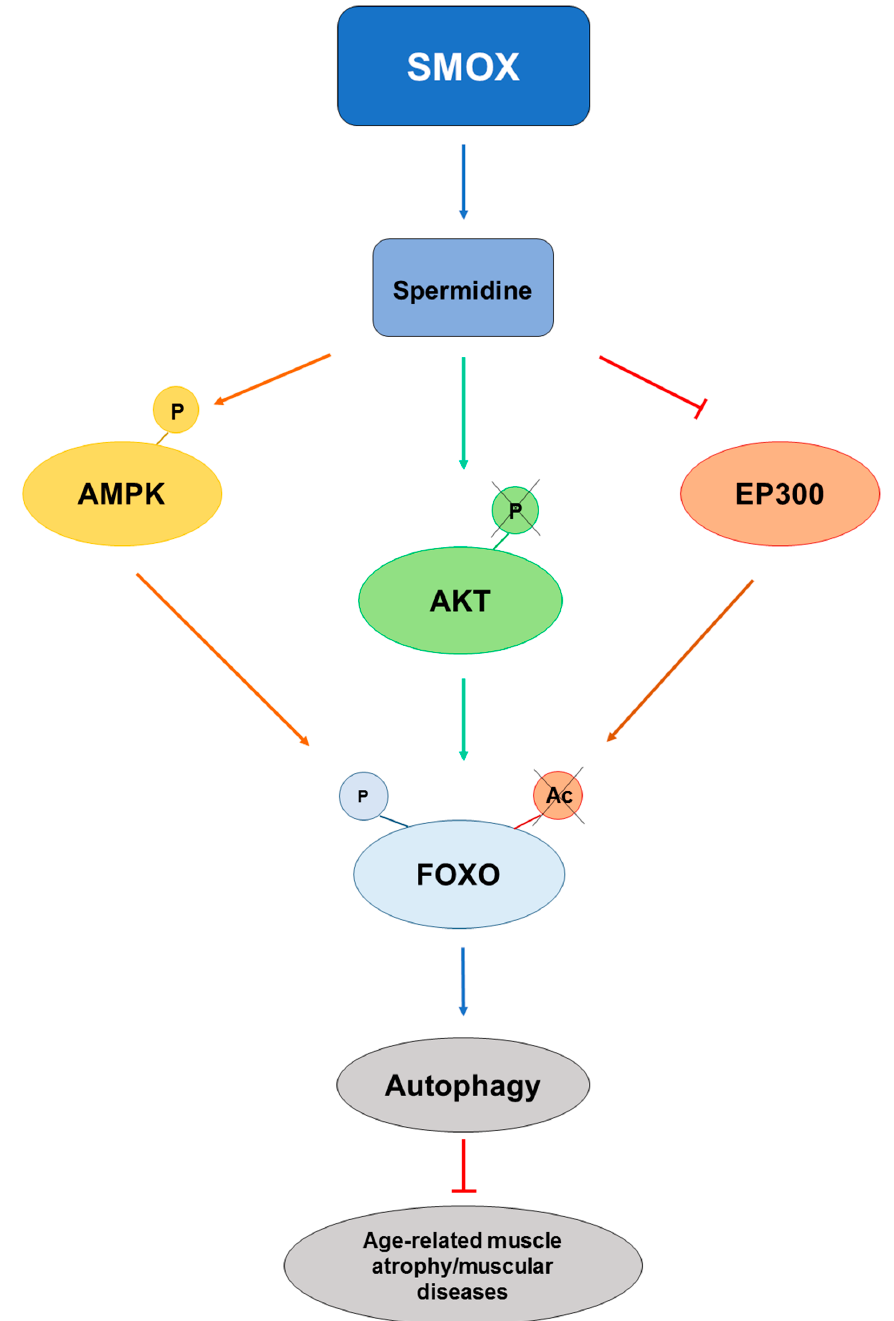
Figure 5. Schematic representation of spermidine effects of on forkhead box (FOXO) activity. The effect of spermidine on the attenuation of age-related skeletal muscle atrophy and diseases, through regulating autophagy via 5 ′ AMP-activated protein kinase (AMPK)/Protein Kinase B (AKT)/E1A binding protein p300 (EP300)-FOXO signal pathways.